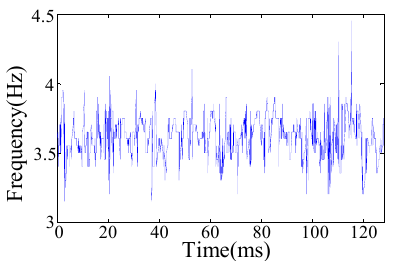
Figure 21. Wavelet ridge of bearing signals for improved wavelet scalogram.